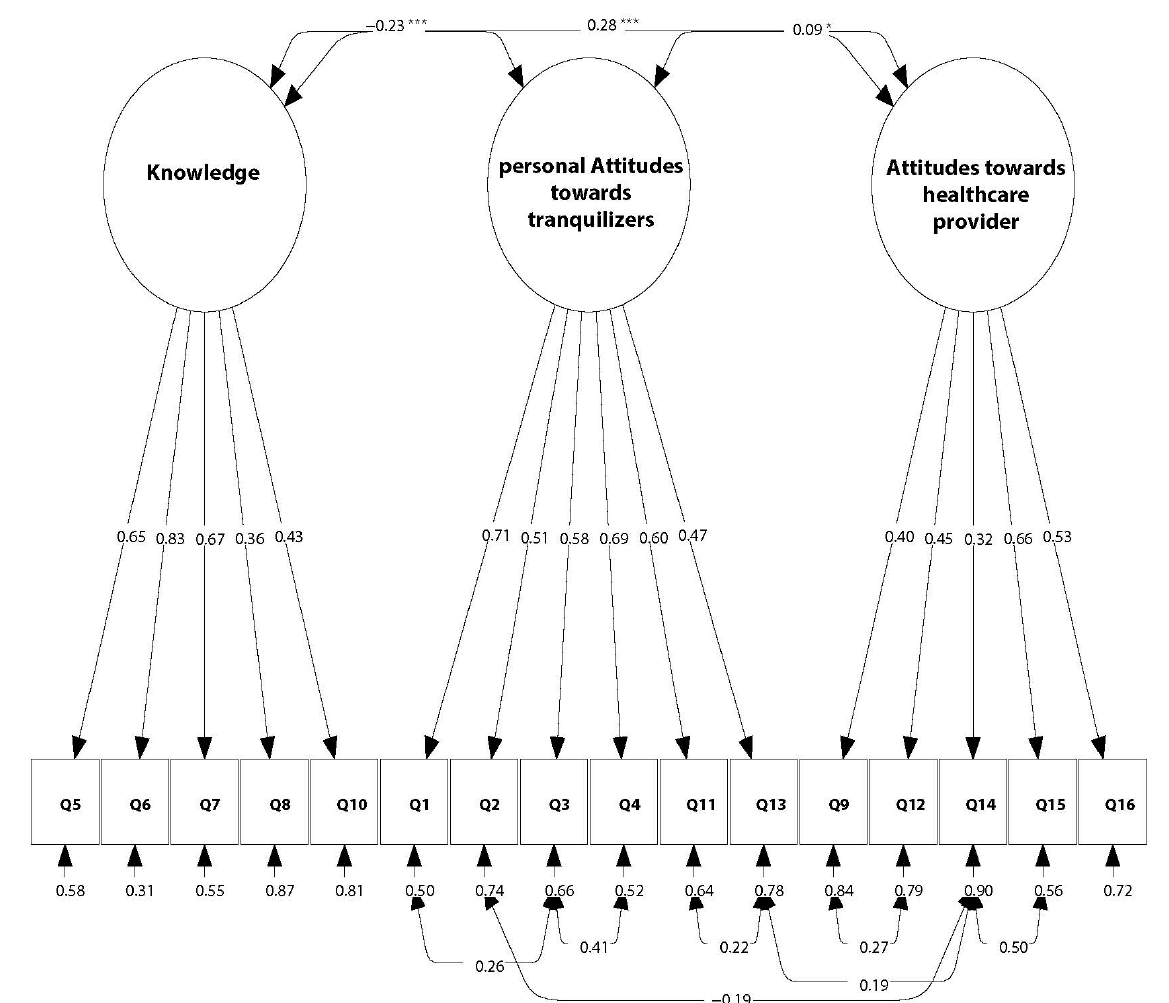
Figure 1. Chosen model for Knowledge and Attitude statements about tranquilizer in Lebanon. Figure represents the three factors of the model: Knowledge, personal Attitudes towards tranquilizers and Attitudes towards Healthcare providers, along with their corresponding standardized item loadings and item residuals. Double-sided arrows correspond to correlations between the variables. Single-headed arrows indicate the correlation of each item with its respective factor. The asterisks represent the level of significance: *** and * correspond to p -values < 0.0001 and < 0.01, respectively.